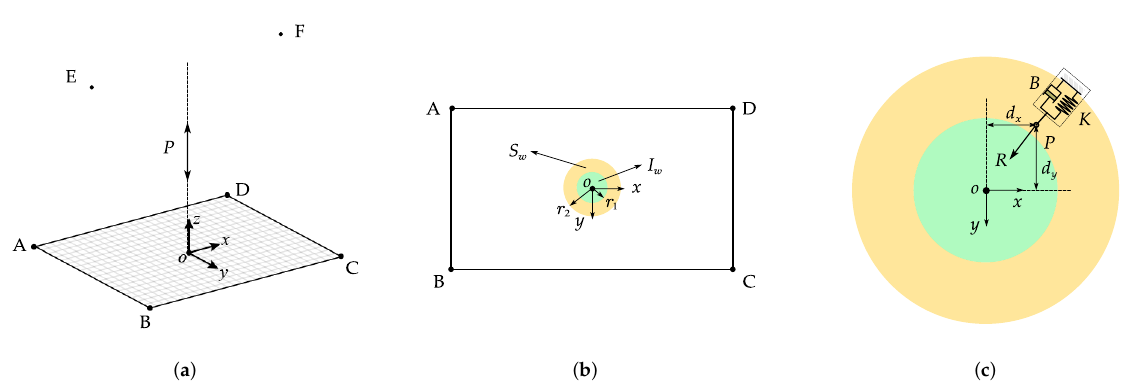
Figure 7. ( a ) ideal track of load position in running exercise; ( b ) projection of load position on the base of CAPE; ( c ) countermeasure strategy for load position offset.